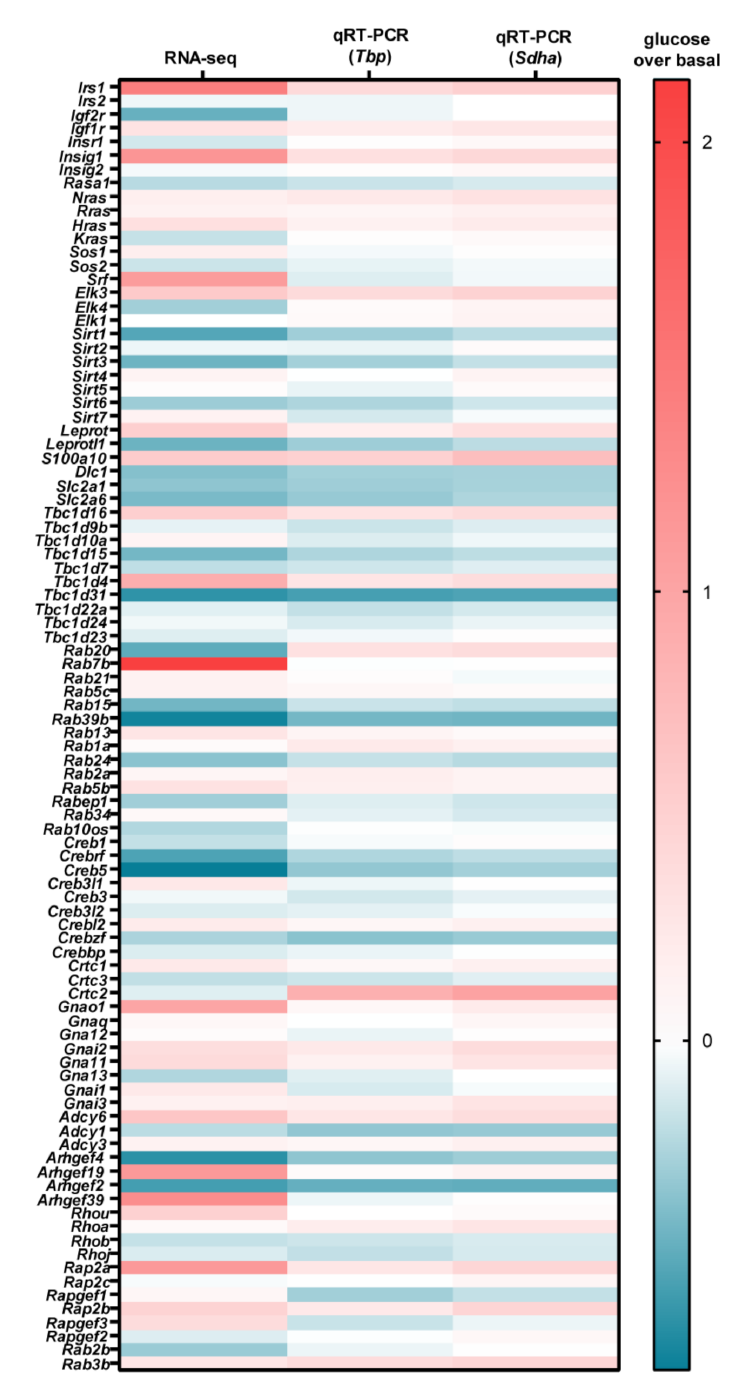
Figure 6. Heat map of glucose-dependent gene expression in mHypoA-2/10 cells combining RNA- seq and qRT-PCR data in mHypoA-2/10 cells. mHypoA-2/10 cells were stimulated accordingly to protocol 1 illustrated in Section 2.5 and RNA levels determined by RNA-seq or qRT-PCR with Sdha or Tbp as a reference gene. Reddish colors indicate gene induction; blueish colors indicate depression. For qRT-PCR experiments, data of 3 independent (N = 3) experiments performed in triplicate are shown. Data are also provided in Table